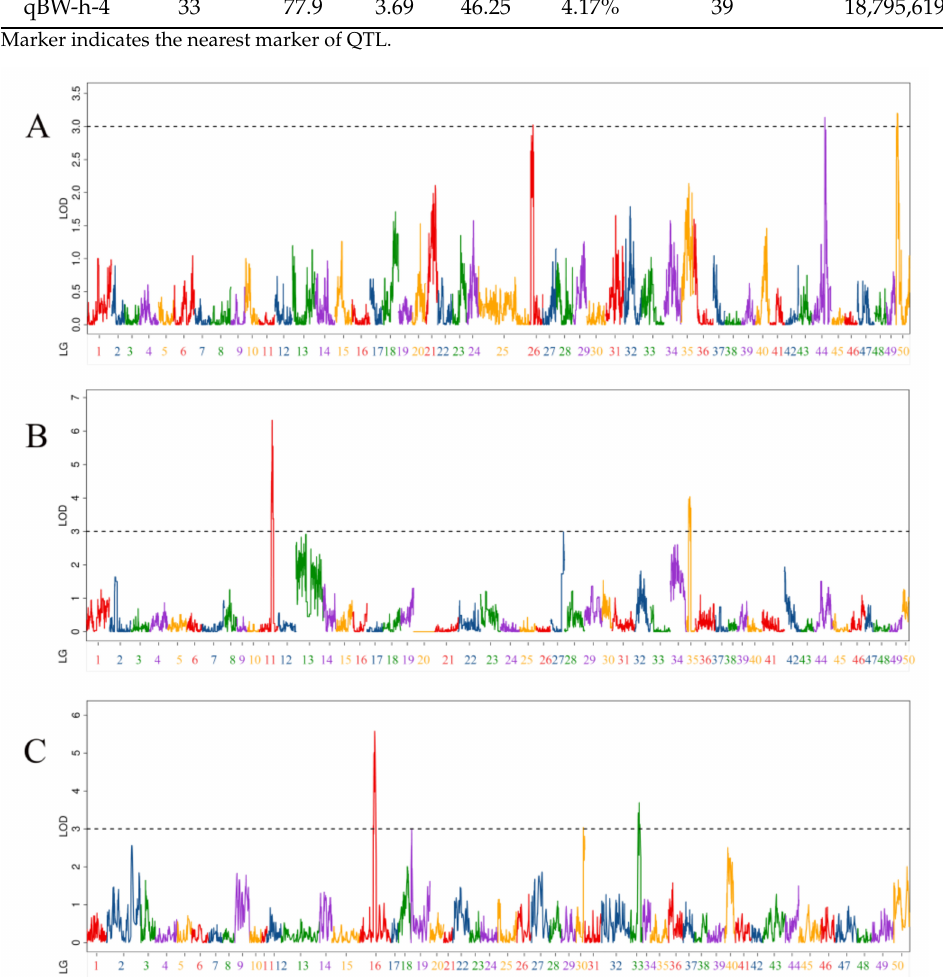
Figure 4. Distribution of body weight–related QTL across 50 linkage groups of Yellow River carp from the maternal ( A ), paternal ( B ), and HH maps ( C